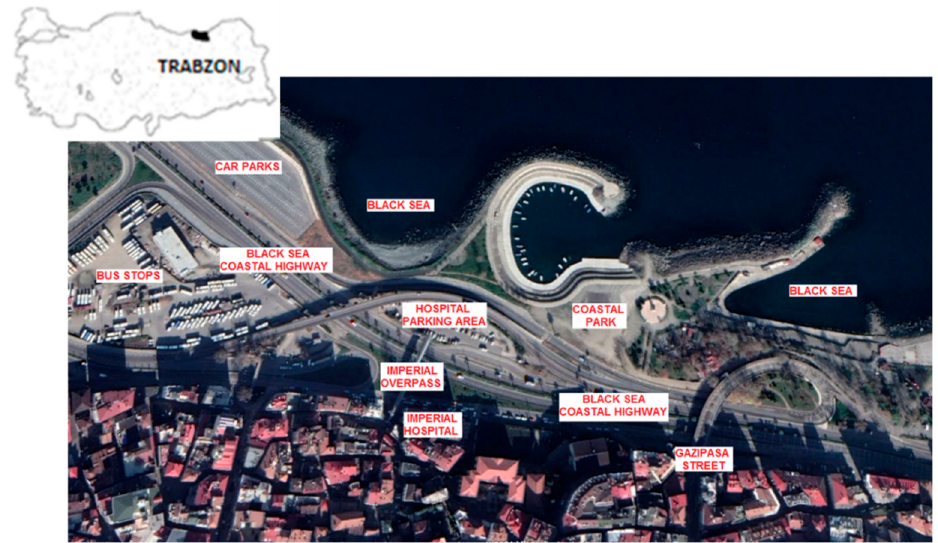
Figure 1. Satellite image showing the study area. Source: own study. Steel was used in the construction of the footbridge, and the floor is of cast concrete. One abutment is located over a section of road in a residential area, while the other is connected to the hospital parking area (Figures 2 and 3).